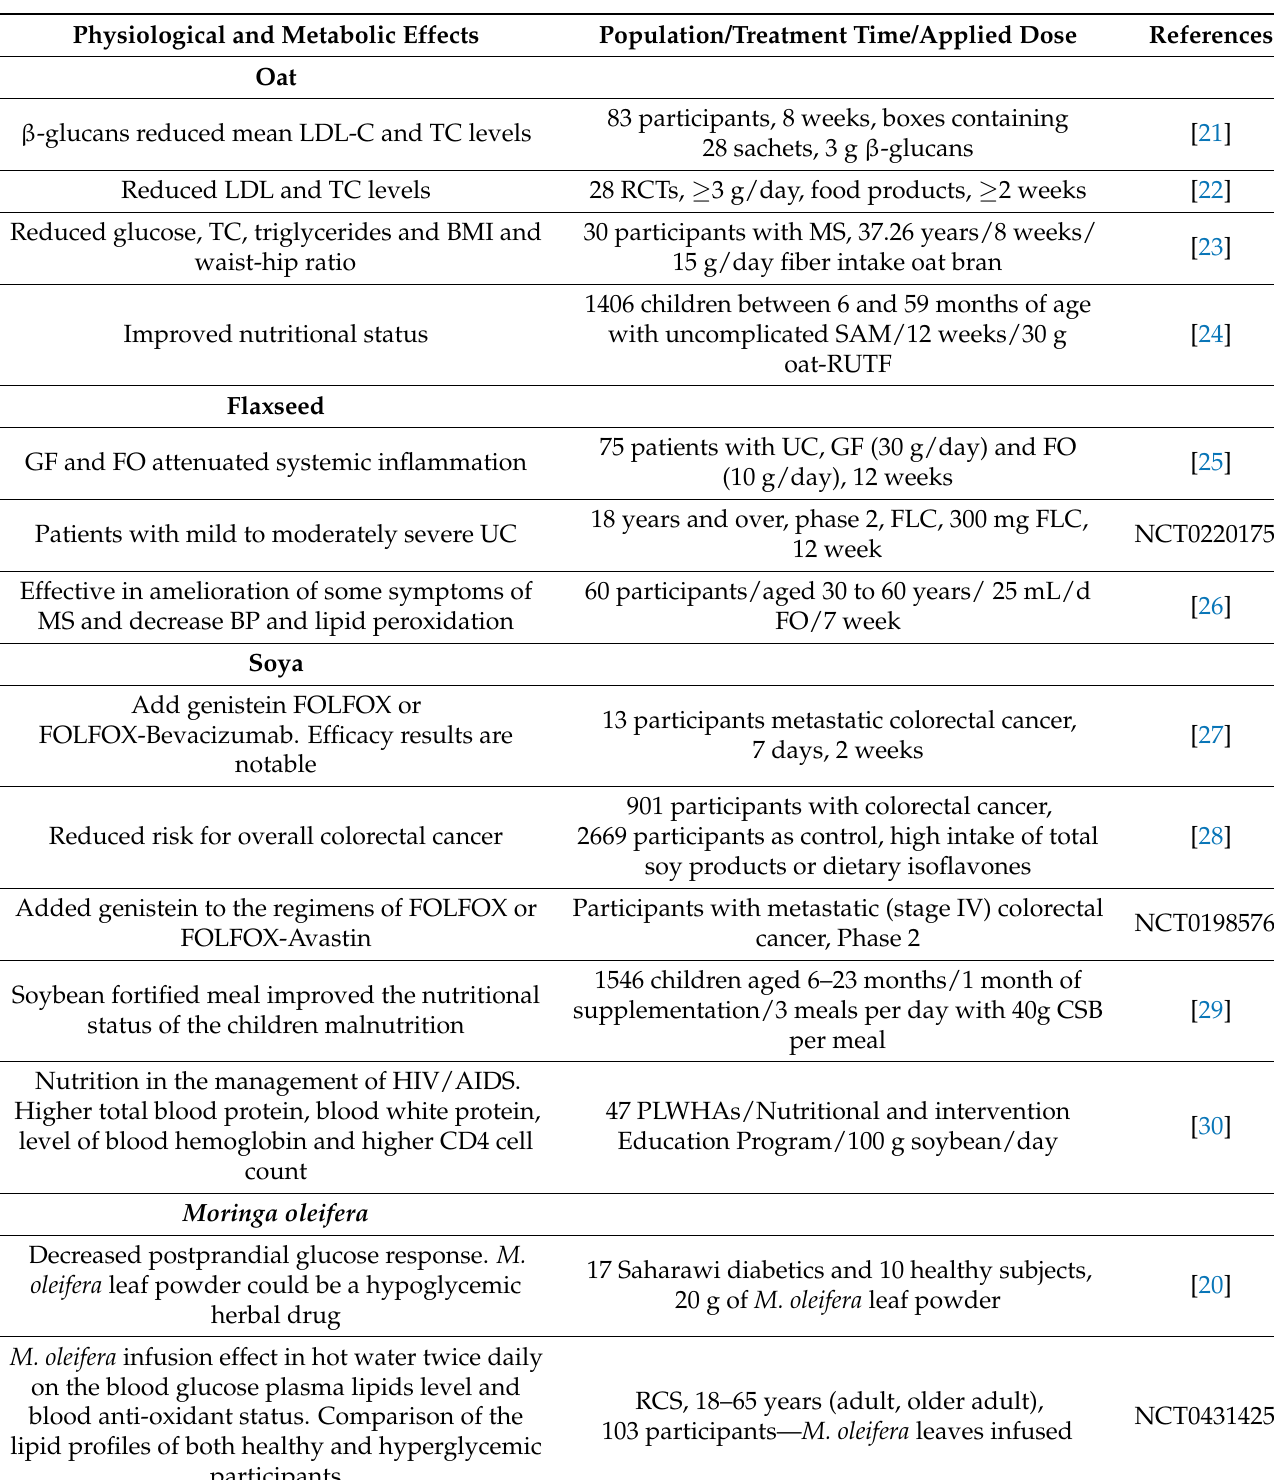
Table 1. BFC and M. oleifera nutraceutical bioactivity in clinical